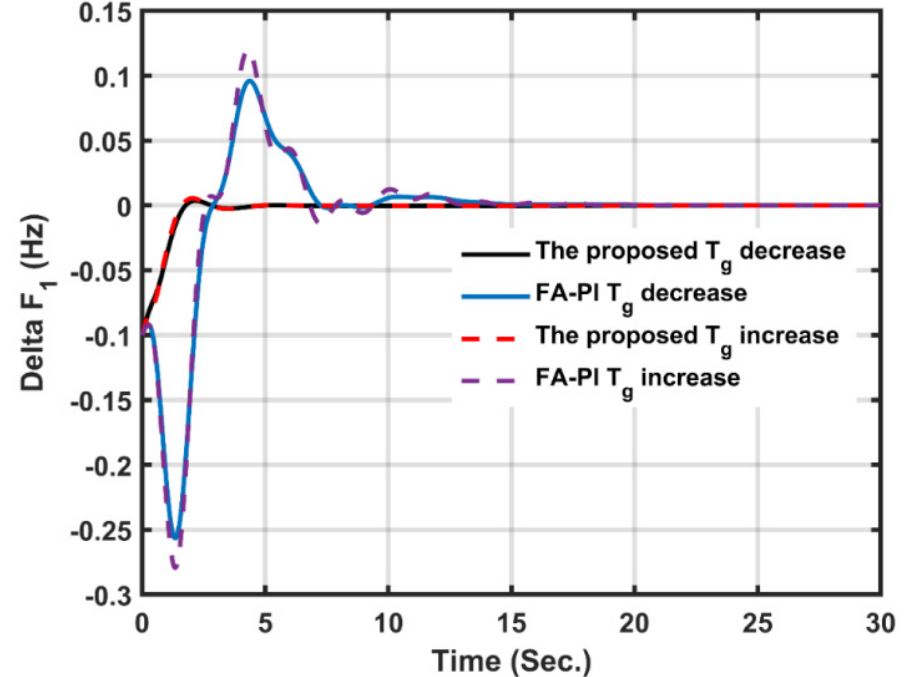
Figure 22. Frequency deviation in area 1 under T g changes.